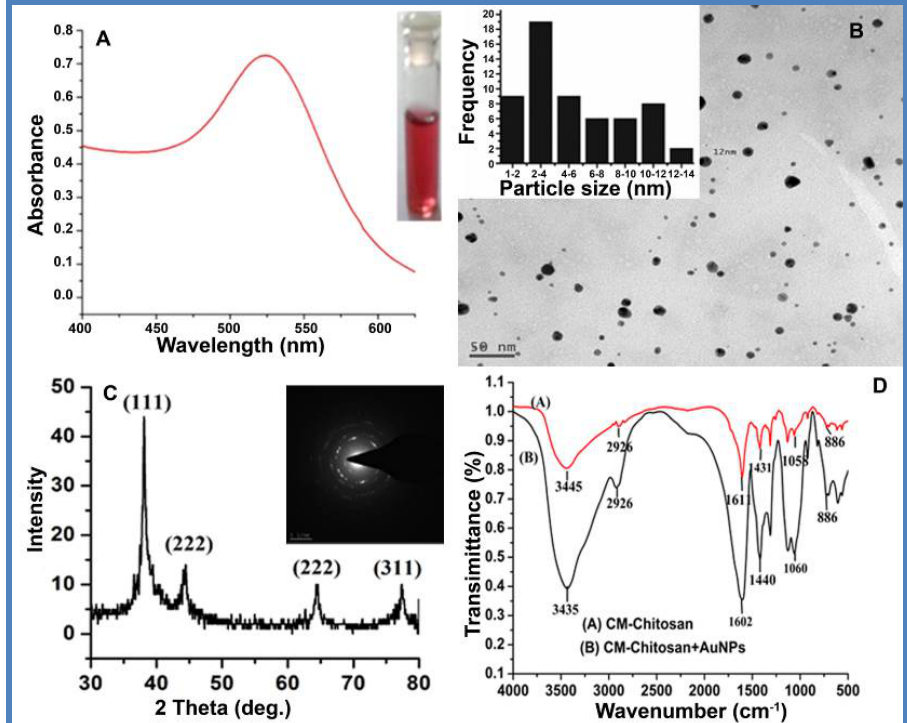
Figure 1. Spectral analysis of AuNPs stabilized in CM-Chitosan (CMC). ( A ) UV-visible spectra of gold nanoparticles (AuNPs) stabilized in CM-Chitosan; ( B ) Transmission electron microscopy (TEM) image of blank gold nanoparticles stabilized by CMC and inset image shows particle size distribution graph; ( C ) X-ray diffraction (XRD) pattern of AuNPs stabilized in CMC, and inset image showing selective electron diffraction pattern of AuNPs stabilized in CMC; and ( D ) Fourier transform infrared spectroscopy (FTIR) spectra of pure CMC and AuNPs stabilized in